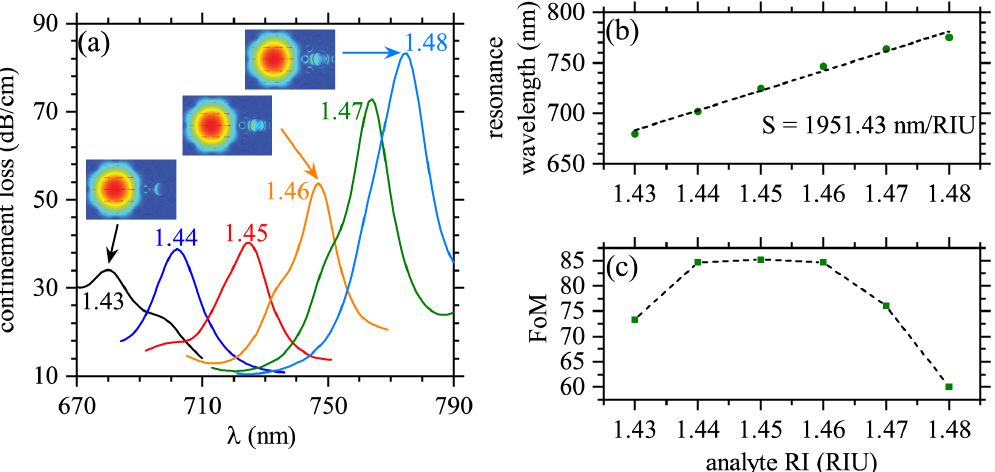
Figure 5. ( a ) Confinement loss for x -polarized light ( α x ) is presented as function of the wavelength for different refractive indexes of the analyte medium. The electric field profiles are shown in the insets for some peaks, as indicated by arrows. The corresponding refractive index of the analyte is shown in the corresponding α x peak. ( b ) Wavelength of the peak in α x as function of the refractive index of the analyte medium. Dashed line corresponds to the linear fitting of the results, with a slope (sensitivity) of 1951.43 nm/refractive index unit (RIU). (c) A FoM defined as the ratio between the sensitivity-peak S ( λ peak ) and the corresponding full width at half maximum (FWHM), FoM = FWHM